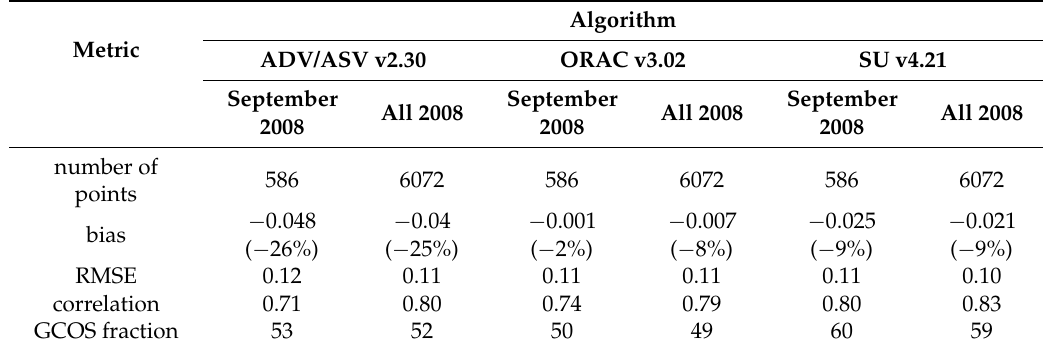
Figure 5. Monthly means of total AOD at 550nm for September 2008 derived from daily data from three AATSR retrievals. In the upper panels all data points retrieved by the different algorithms are used, in the lower panels only those data points where all three algorithms provided a valid retrieval are averaged. Global average AOD is given above the figures. Table 5. Statistics of L3 evaluation of the three AATSR retrievals against AERONET on common data points for September and the entire year 2008.